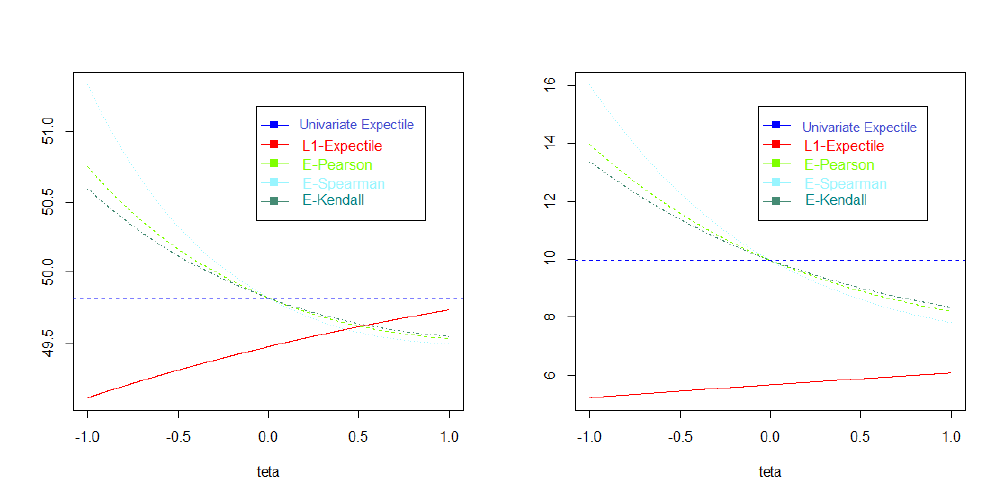
Figure 3: Impact of dependence in FGM bivariate model for α = 0.95 (left X 1 ∼ E (0.05) , right X 2 ∼ E (0.25)